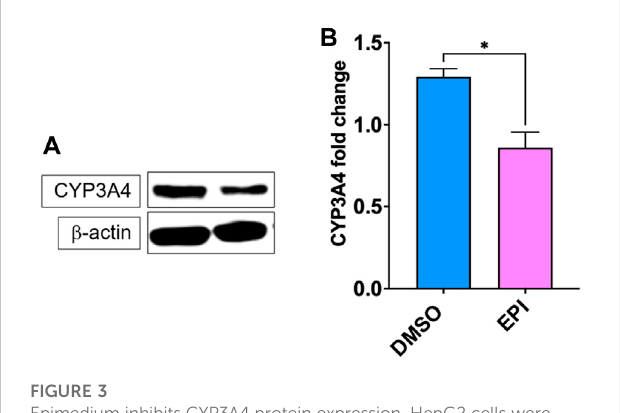
FIGURE 4 Epimedium and dexamethasonesynergistically suppressed TNF- α production: RAW cells were cultured with Epimedium either alone or in combination with Dexamethasone for 24 h. The cells were stimulated with LPS (0.5 pg/mL). The supernatant were harvested and TNF-a levels were measured by ELISA. (A) Dexamethasone (10 − 6 M, 10 − 7 M) and Epimedium (125 pg/m1) signi fi cantly reduced TNF- α levels. When Epimedium was added to dexamethasone, the TNF- α levels were suppressed by 88%. Data represents triplicate experiments and expressed as mean ± SD. *** p < 0.001 vs . control (0.1%DMS0),"# p < 0.001 vs . Dex (10 – 7 M).